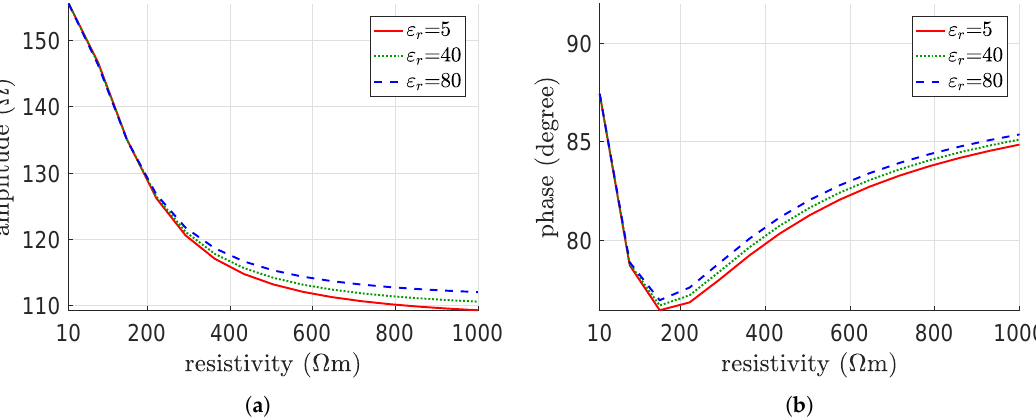
Figure 13. Equivalent impedance of the embedded coil ( Mod1 ) at 85 kHz for a concrete resistivity from 10 Ω m to 1000 Ω m, parametrized for ε r equal to 5, 40, and 80. Amplitude ( a ); phase ( b ).